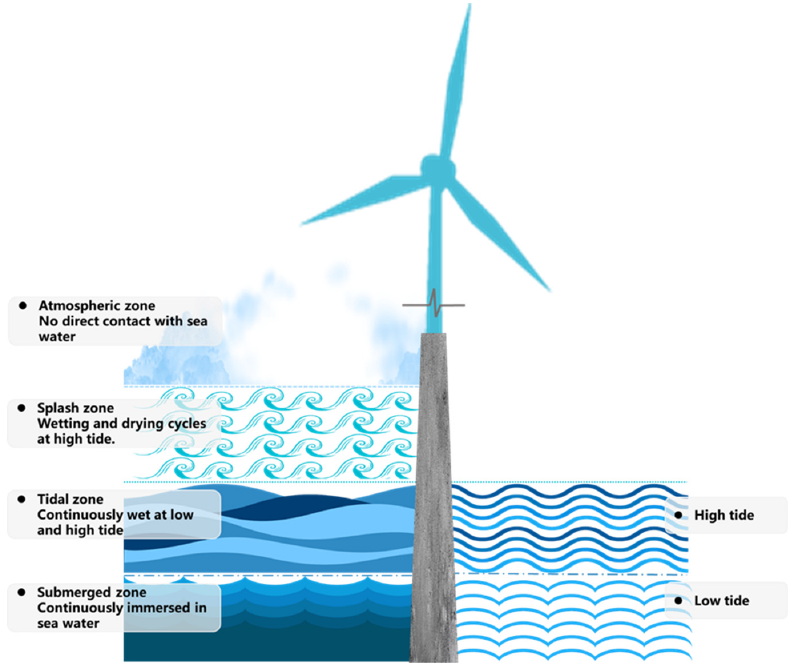
Figure 1. Different exposure conditions. Figure 1. Di ff erent exposure